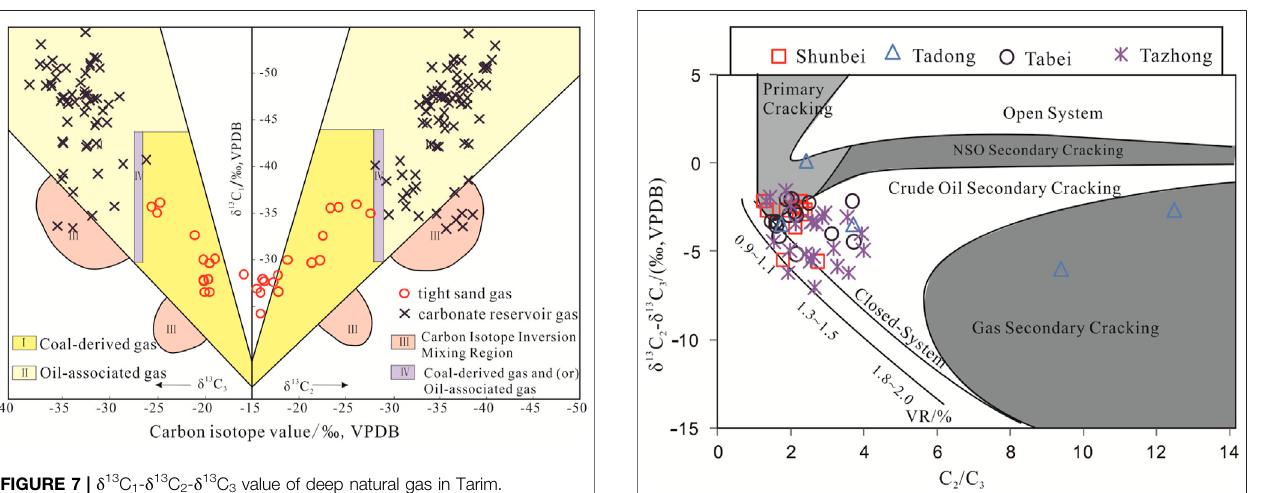
FIGURE 7 | δ 13 C 1 - δ 13 C 2 - δ 13 C 3 value of deep natural gas in Tarim.